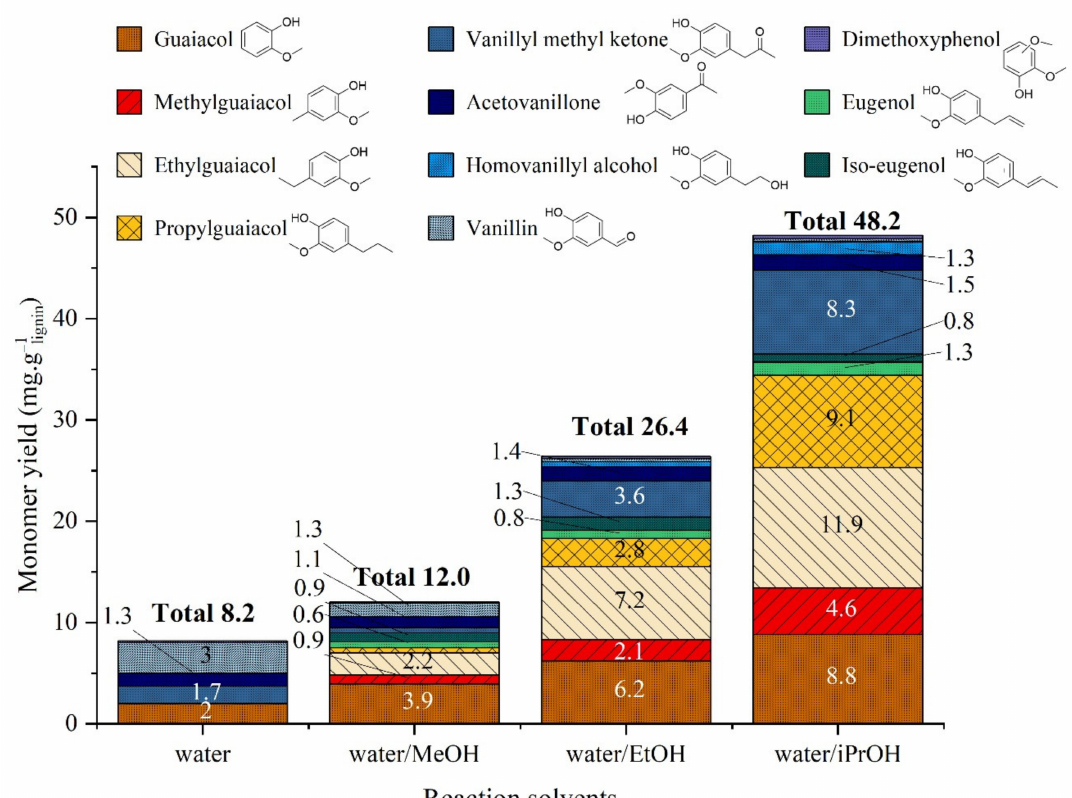
Figure 10. Yield of monomeric products in organic phase after lignin liquefaction in water/alcohol mixtures. Reaction conditions: Kraft lignin 10 g · kg − 1 , 3 h, 225 ◦ C, 40 bar